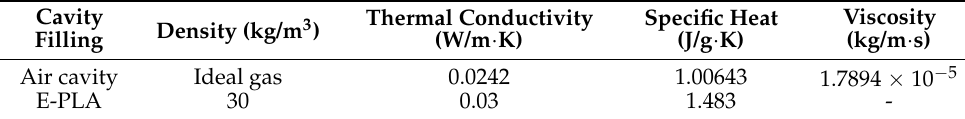
Table 2. Thermophysical properties of the cavity insulation [31].